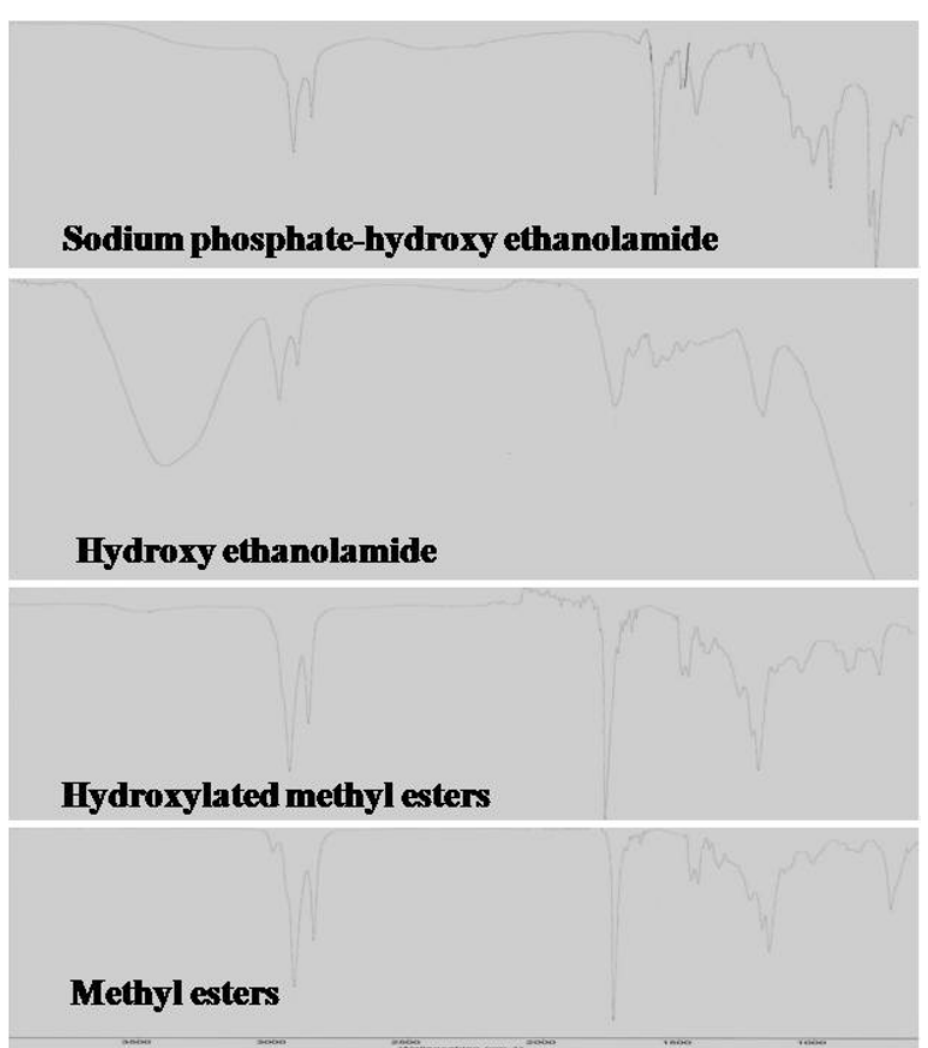
Figure 1. FTIR spectra of the methyl esters, hydroxylated methyl esters, hydroxy ethanolamide and sodium phosphate-hydroxy ethanolamide of luffa cylindrica.